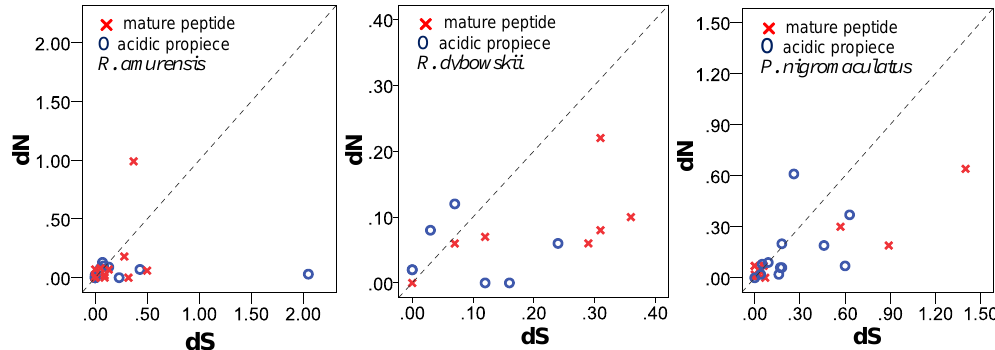
Figure 13. Plots of d N against d S of the propiece and the mature peptide region for three anuran species. The broken line is the neutral line (ω = 1).